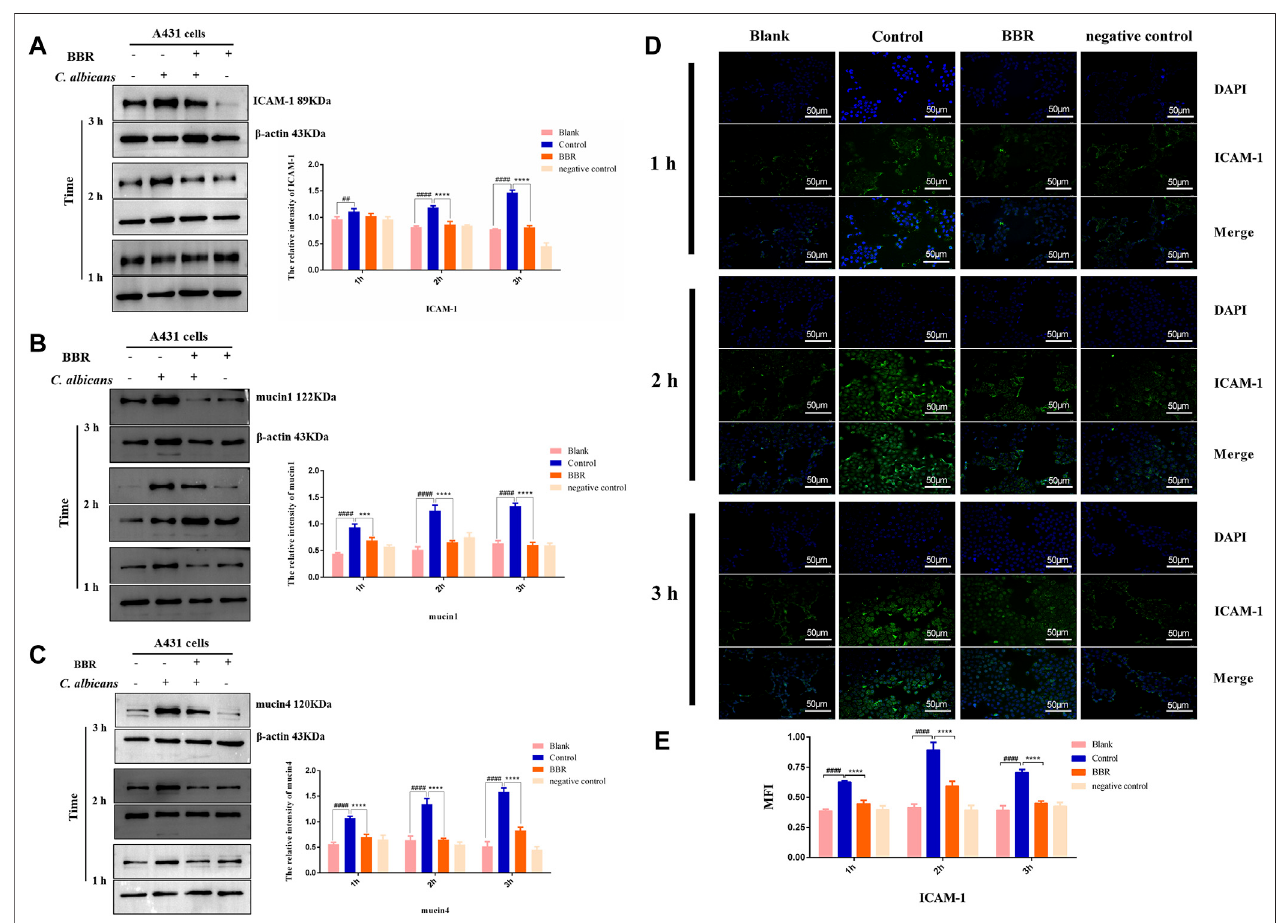
FIGURE 5 | Western blot and quanti fi cation of the expression levels of (A) ICAM-1 (B) mucin1 and (C) mucin4 in A431 cells of the Blank, Control, BBR(32 μ g/ml) and negative control groups at 1, 2, 3 h, respectively. (D) Observation and (B) quanti fi cation of BBR on the expression of adhesion molecule ICAM-1 in A431 cells stimulated by C. albicans at 1, 2, 3 h, respectively. ## p < 0.01, #### p < 0.0001. vs. Blank group; *** p < 0.001, **** p < 0.0001. vs. Control group. Scale bar, 50 μ